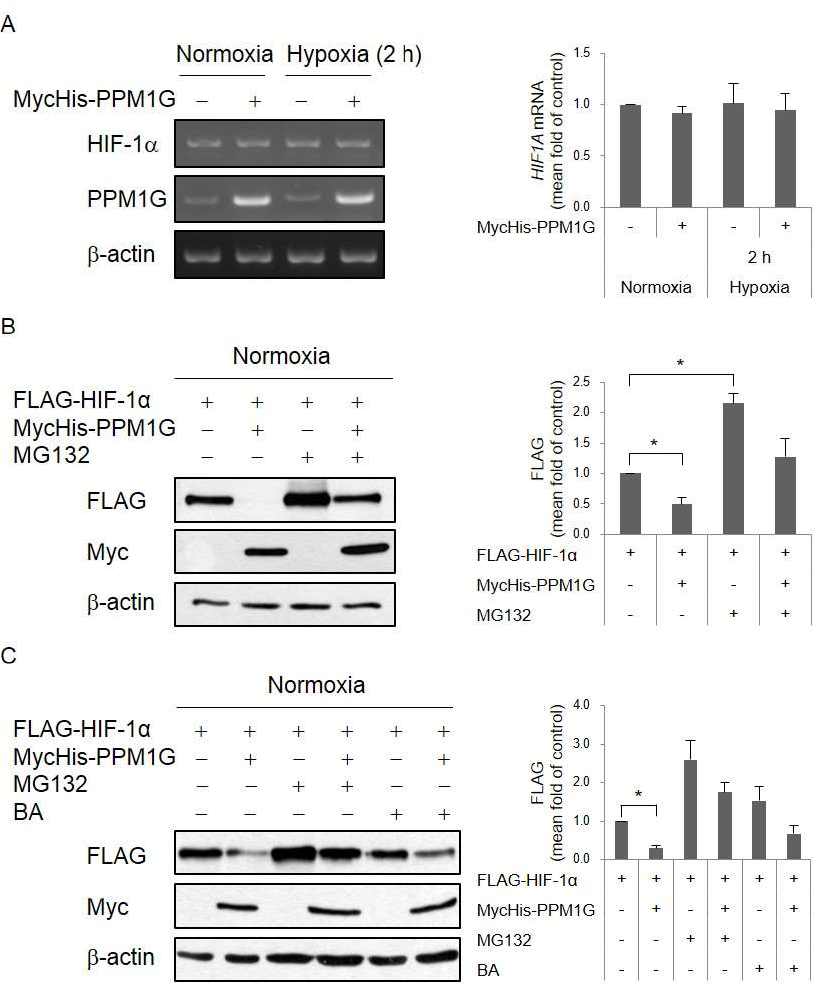
Figure 3. PPM1G induces proteasomal degradation of HIF-1α. HEK293T cells were co-transfected with FLAG-HIF-1α and MycHis-Empty (−) or MycHis-PPM1G (+), and exposed to normoxia or hypoxia. ( A ) mRNA expressions of the HIF-1α and β-actin were measured by RT-PCR; ( B , C ) Expression of each protein was determined by Western blotting. ( B ) Proteasome-mediated protein degradation was blocked by treating cells with 10 µM MG132 for 6 h prior to lysis; ( C ) Proteasome- and lysosome-mediated protein degradation was blocked by treating cells with 10 µM MG132 and